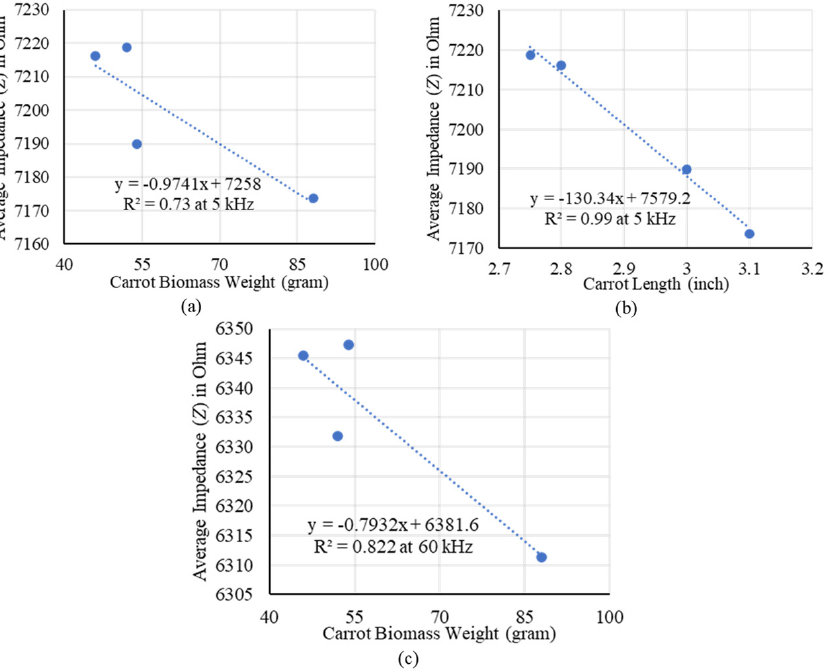
Figure 17. Correlation between ( a ) average impedance and biomass weight, and ( b ) average impedance and length of the carrot at 5 kHz. A negative correlation is found between the carrot size (such as weight and length) and average impedance. An improved correlation is found between ( c ) average impedance and biomass weight of the sample at a high frequency of 60 kHz. Overall, the average impedance is decreased by increasing frequency and the correlation is improved for estimating the carrot root biomass.